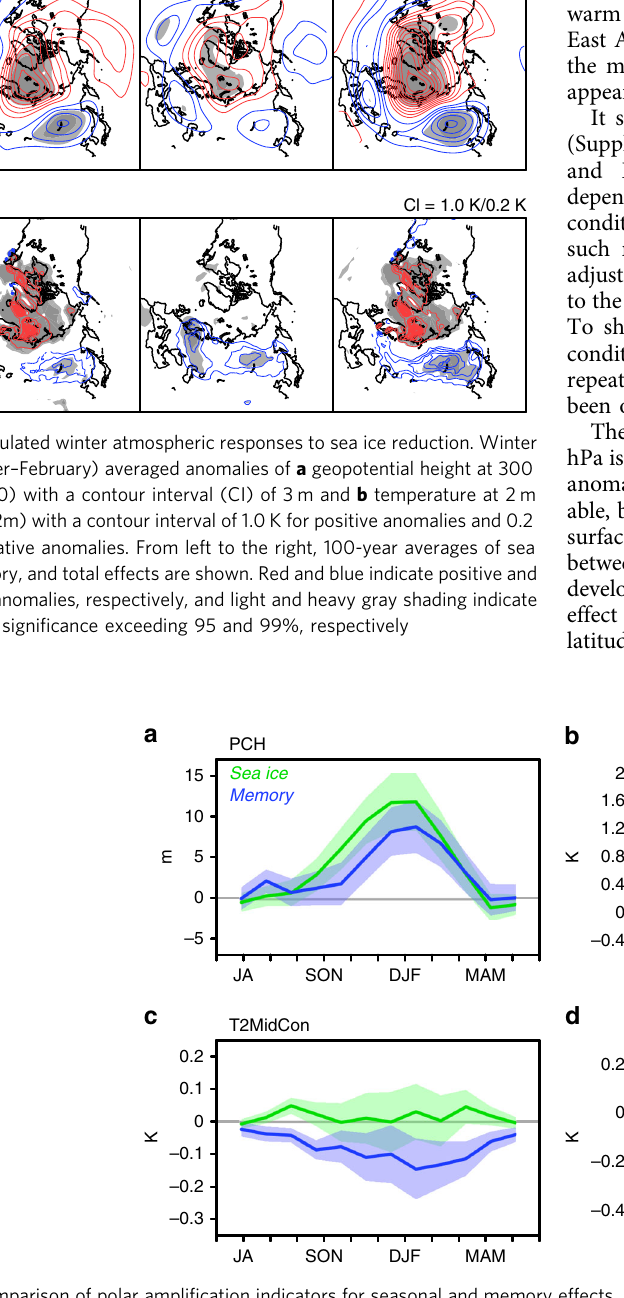
Fig. 3 Comparison of polar ampli fi cation indicators for seasonal and memory effects. Annual evolutions of 3-month mean anomalies of a polar cap height (PCH) at 300 hPa, b polar cap temperature (PCT) at 2 m height, c continental 2 m temperature averaged over 40 – 60°N latitude (T2MidCon), and d 2 m temperature averaged over the Siberian region (90 – 140°E and 40 – 60°N) (T2Sib). Polar cap is de fi ned as northward of 65°N. Green and blue indicate anomalies of sea ice and memory effects, respectively. Shading indicates the denominator of the t value ( = σ / N 1/2